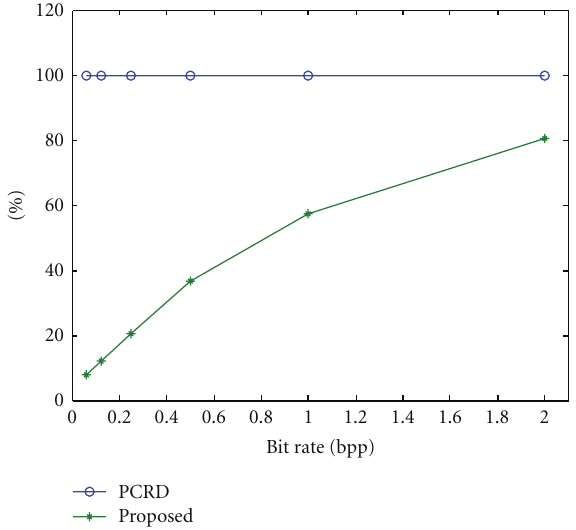
Figure 3: Average memory usage percentages for the PCRD and proposed